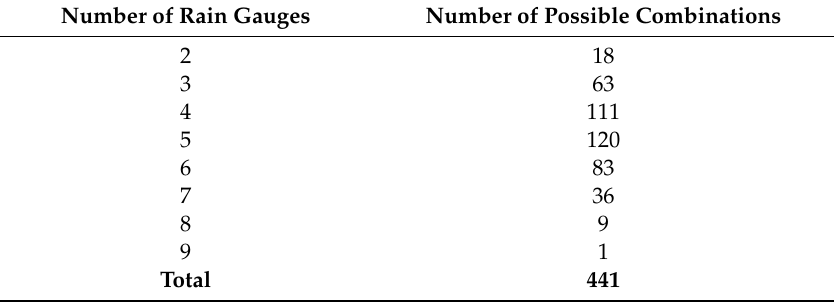
Figure 5. Approach used for the sensitivity analysis of the model input in the study area. Table 5. Number of possible combinations or subsets using di ff erent number of rainfall